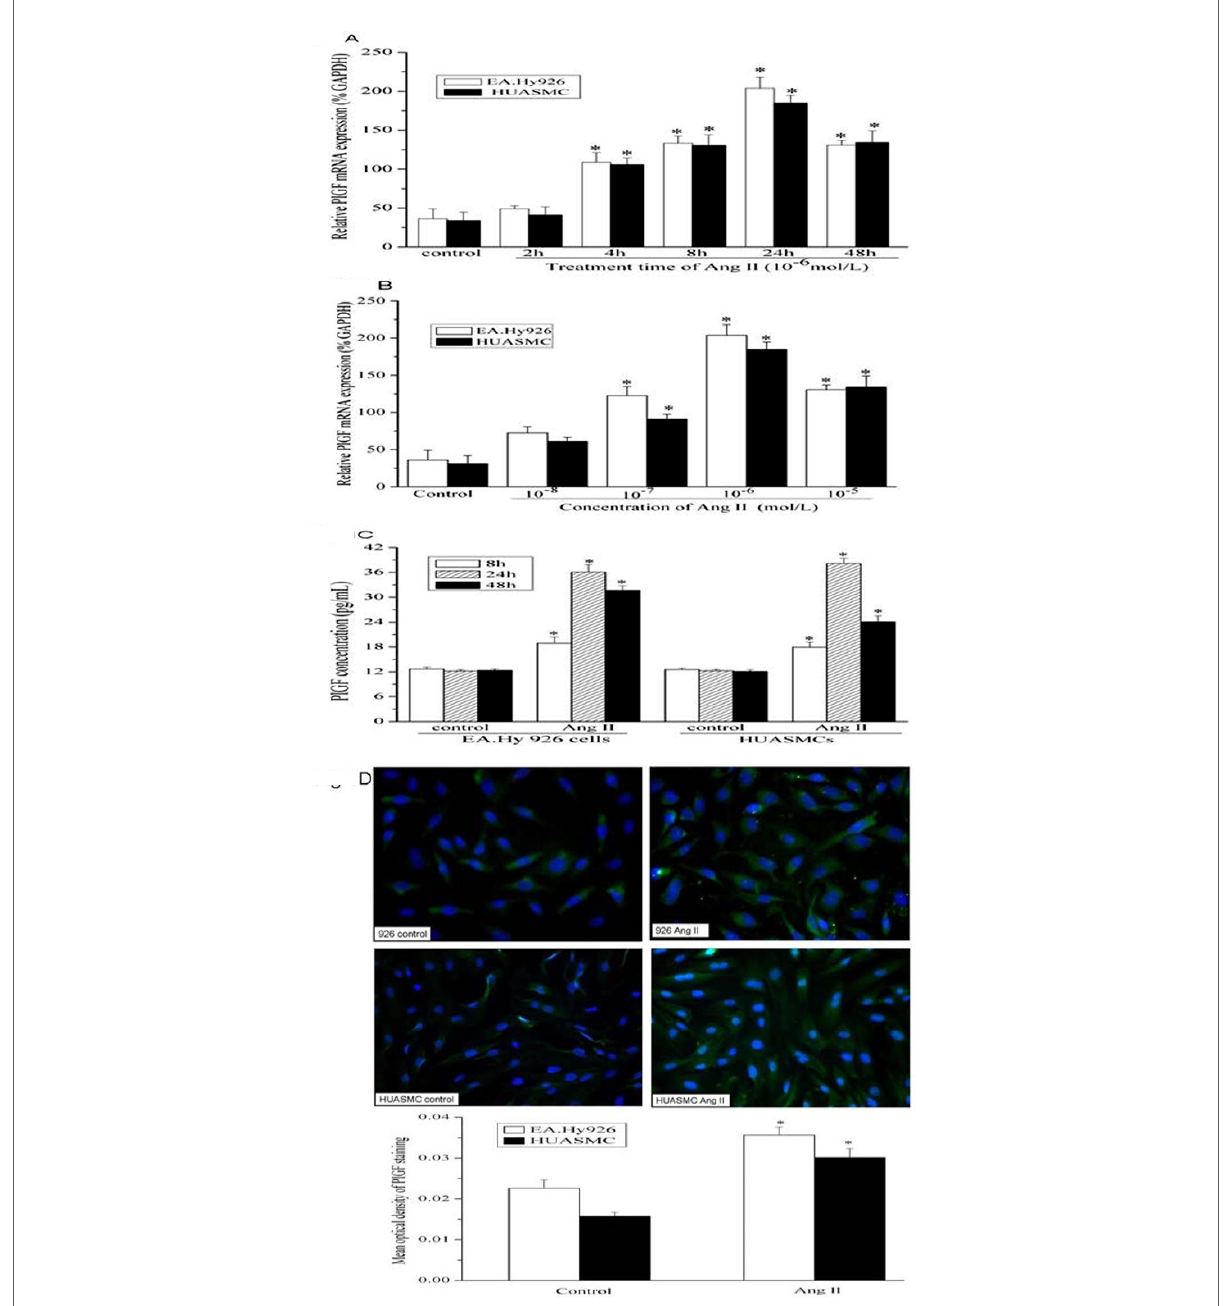
Figure 1 Angiotensin II increases PlGF mRNA expression (A, B) and protein production (C, D) in EA.Hy 926 endothelial cells and HUASMCs . Growth-arrested EA.Hy 926 cells and HUASMCs were stimulated with Angiotensin II (10 -6 mol/L) for different durations. (A) Quantitative RT-PCR (Q- PCR) results. Total RNA was isolated from cells. After reverse transcription, they were subjected to quantitative PCR analysis to determine PlGF mRNA level. Graph is representative of relative PlGF mRNA levels in the various conditions. Experiments were performed five times with the similar results (n = 5 in each group). * indicates P < 0.05 vs control EA.Hy 926 cells or HUASMCs. (B) Induction of PlGF mRNA expression is Ang II concentration-depen- dent. * indicates P < 0.05 vs control EA.Hy 926 cells or HUASMCs. (C) Release of PlGF protein measured by ELISA. Cells were incubated with Ang II (10 - 6 mol/L) for 8, 24 or 48 h, and PlGF protein released into cell culture media was measured by ELISA (n = 3 in each group). * indicates P < 0.05 vs control EA.Hy 926 cells or HUASMCs. (D) Expression of PlGF protein detected by immunofluorescence assay. Immunofluorescence detecting of PlGF expres- sion in untreated control cells, and cells stimulated with Ang II (10 -6 mol/L) for 24 hours (original magnification of 200 ×). Mean optical density (MOD) of PlGF staining was measured on the images by using the ImageJ software. The figure shows one of three similar experiments. * P < 0.05 vs control EA.Hy 926 cells or